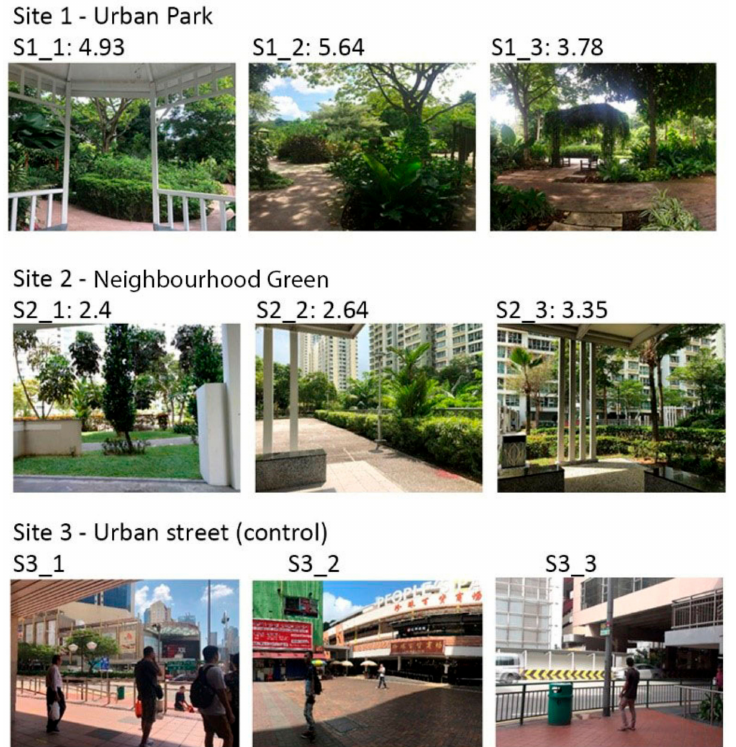
Figure 1. Selected sites and scenes, with contemplative landscape score between 1 and 6 points for each